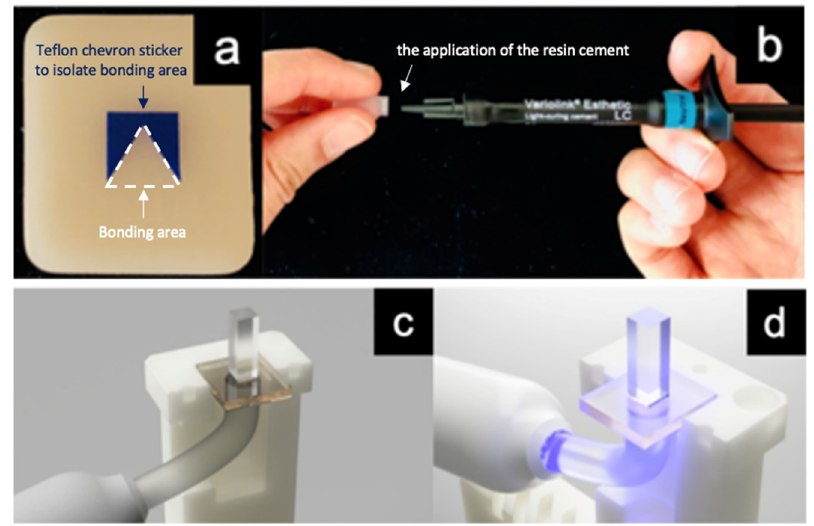
Figure 1. Preparation of specimens for the chevron notch bond strength test, showing ( a ) the chevron notch sticker applied to the face of the ceramic, ( b ) the application of the resin cement to the bonding surface of the beam prior to positioning the beam over the chevron notch, ( c ) and subsequently light-curing using a jig ( d ) to control the positioning of the light-curing tip.